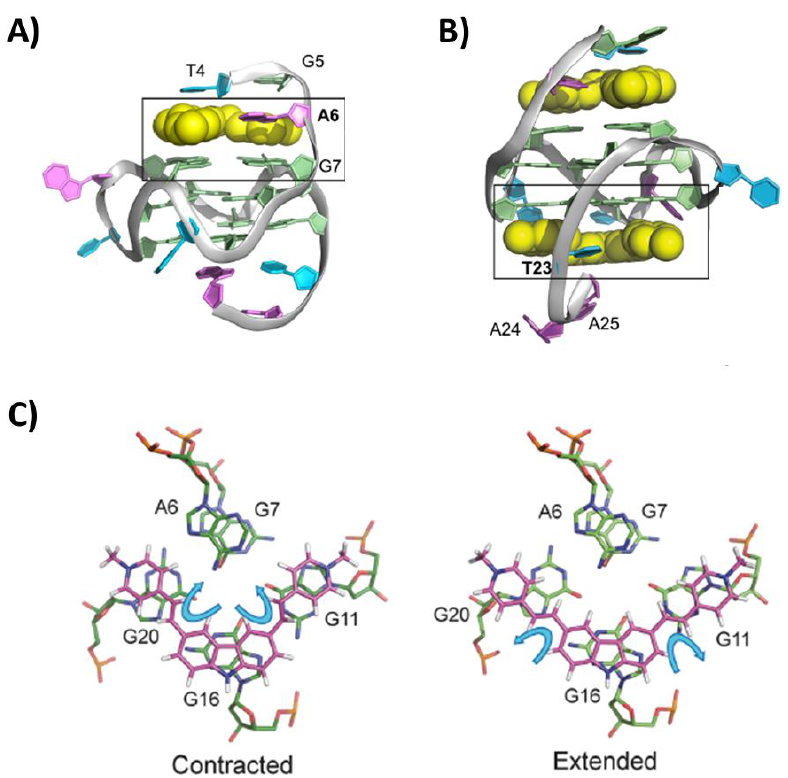
Figure 11. NMR structure of the complex between the unimolecular parallel G-quadruplex Pu22T of sequence d(TGAGGGTGGGTAGGGTGGGTAA) and BMVC at ( A ) 1:1 or ( B ) 1:2 G-quadruplex/ligand stoichiometry. 5′ - and 3′ -ends of the G-quadruplex are at the top and bottom, respectively. ( C ) Comparison between the contracted and extended conformation of BMVC found for its G-quadruplex-bound and free forms. Adapted with permission from ref. [92], Copyright 2019 Oxford University Press.